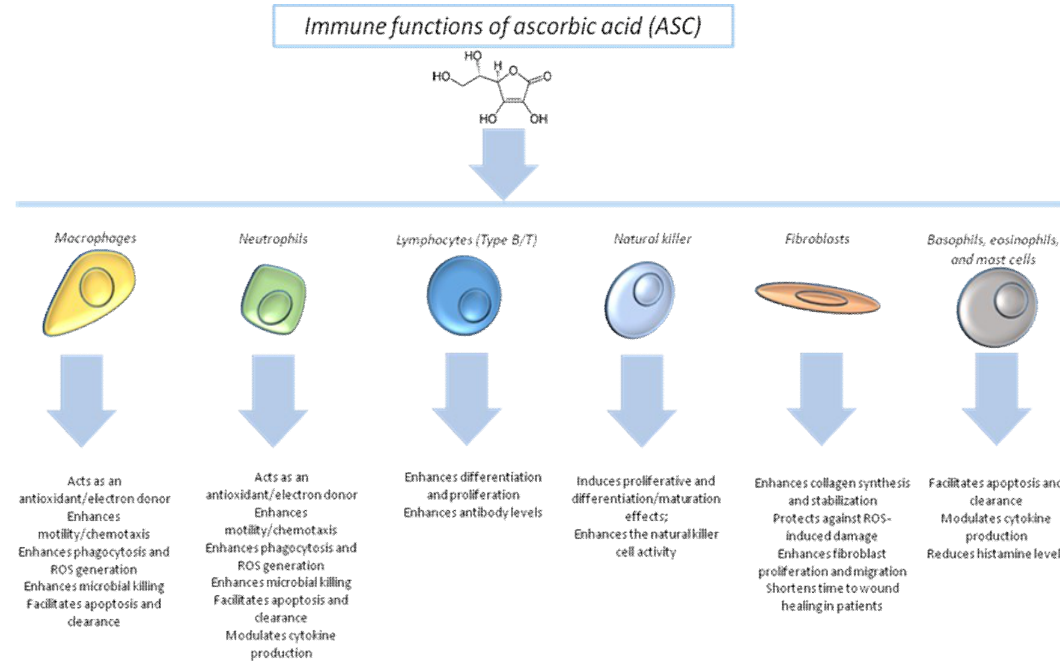
Figure 4. Overall clear effects of ASCon human immune cells.